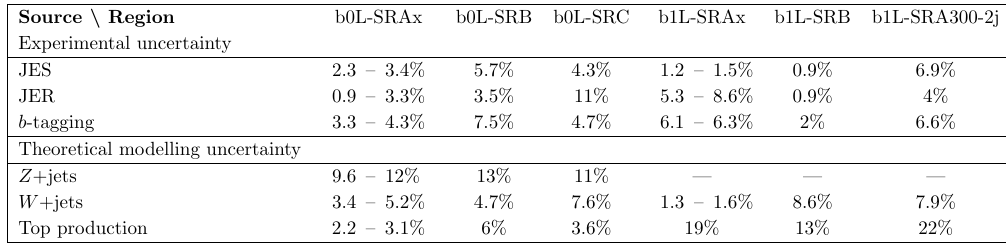
Table 7. Summary of the dominant experimental and theoretical uncertainties for each signal region in zero-lepton and one-lepton channels. Uncertainties are quoted as relative to the total SM background predictions, with a range indicated for the three b0L-SRAs and the two b1L-SRAs. For theoretical modelling, uncertainties per dominant SM background process are quoted. The individual uncertainties can be correlated, and do not necessarily add in quadrature to the total background uncertainty.